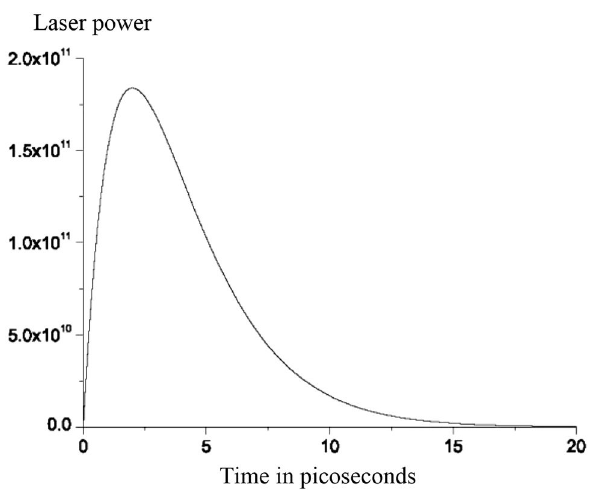
Figure 1. Temporal profile of the laser pulse.